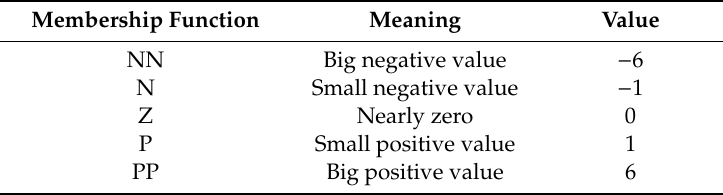
Figure 8. Membership functions with the DOM. Table 1. Definition of membership functions.